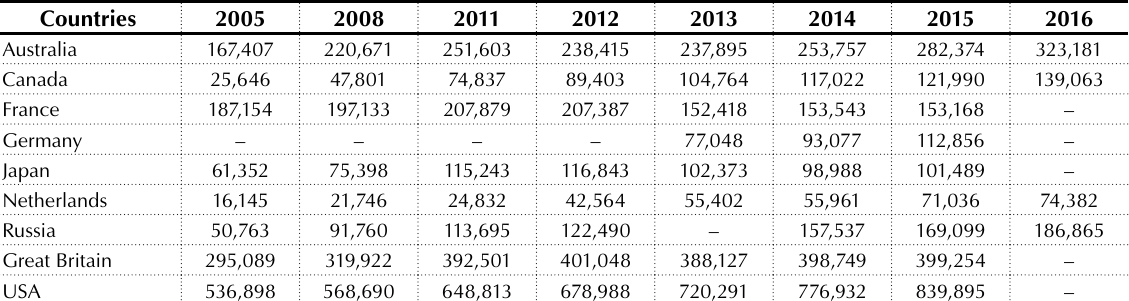
Table 2. Countries with the largest share of foreign students